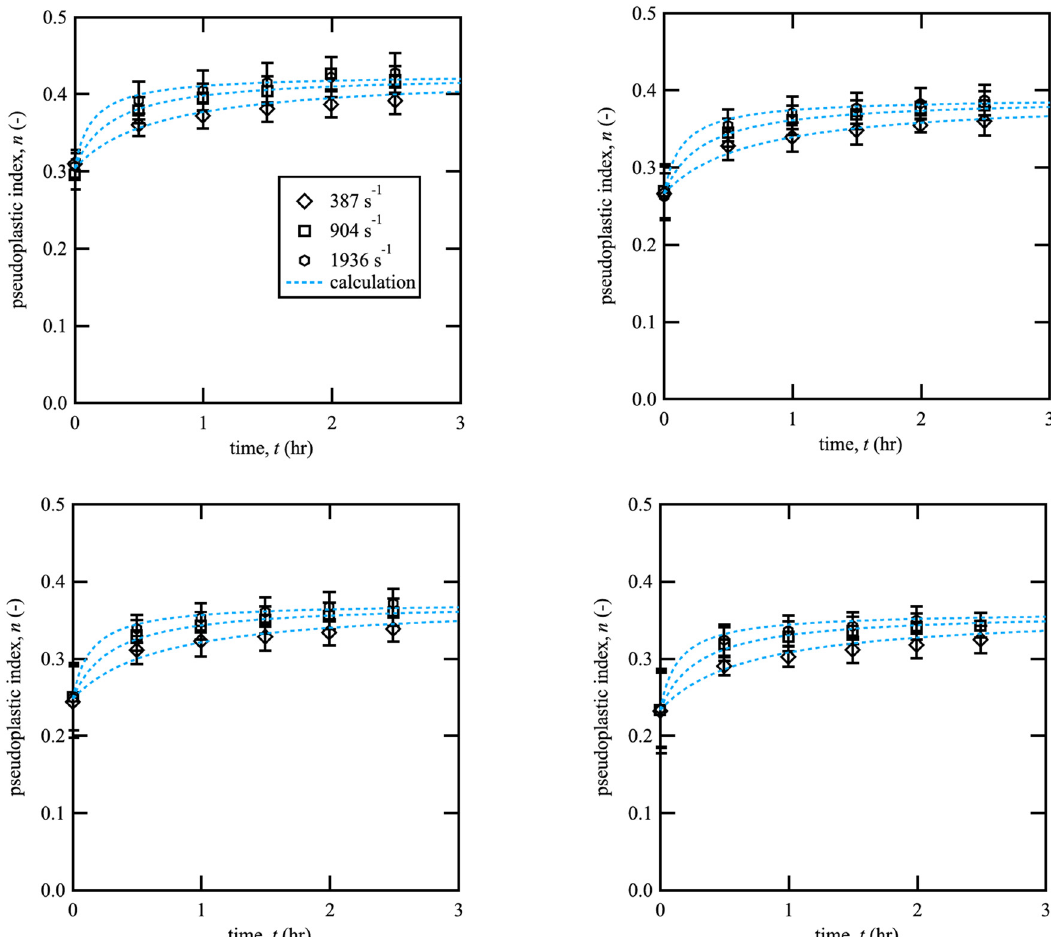
Figure 2 : Change in n with shearing time, C = 42 g/L ( upper - left ) , C = 54 g/L ( upper - right ) , C = 63 g/L ( bottom - left ) , and C = 70 g/L ( bottom - right ) .